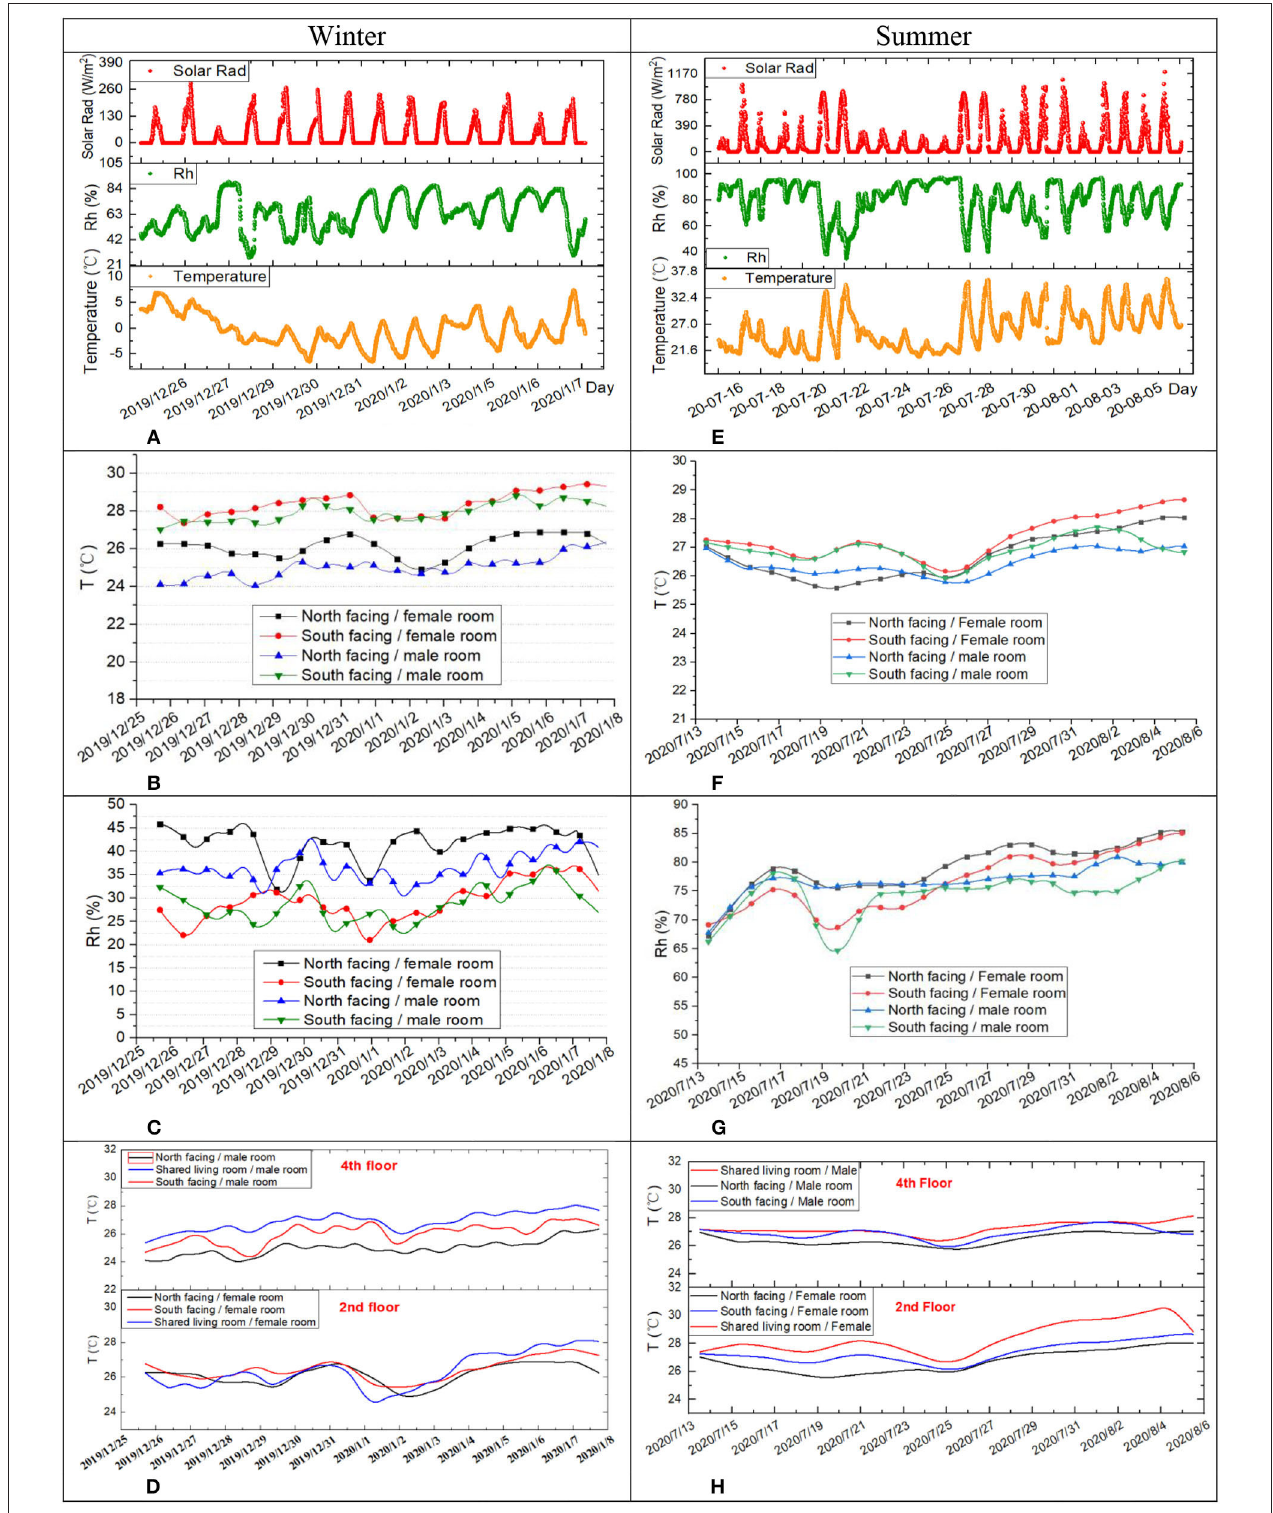
FIGURE 4 | Test results in winter and summer. (A) Outdoor parameters during winter test. (B) Indoor temperature. (C) Indoor relative humidity. (D) North, South, and shared living room. (E) Outdoor parameters during summer test. (F) Indoor temperature. (G) Indoor relative humidity. (H) North, South, and shared living room.